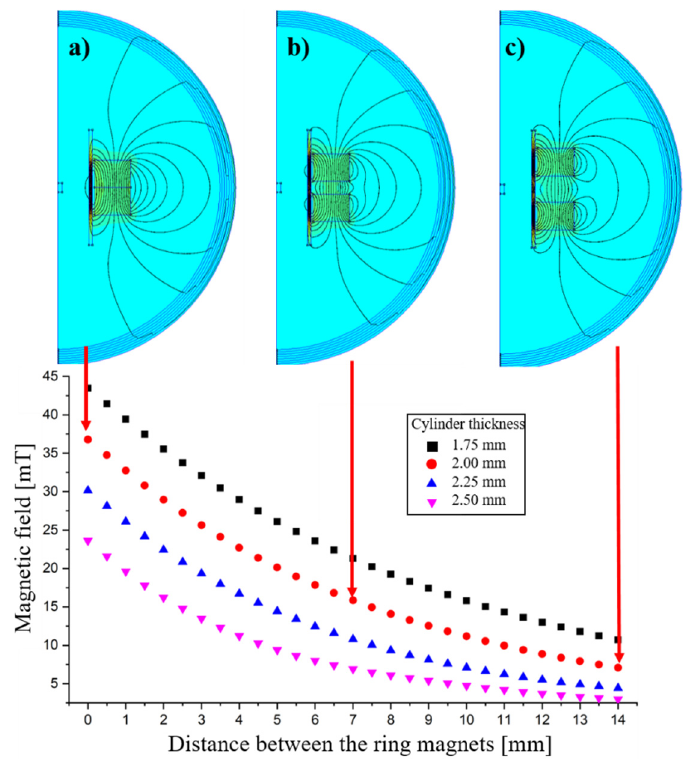
Figure 3. Simulated magnetic field as a function of the distance between the two magnets with steel cylinders of different thicknesses (color-coded). The magnets are moved symmetrically away from each other, as shown in ( a – c ).